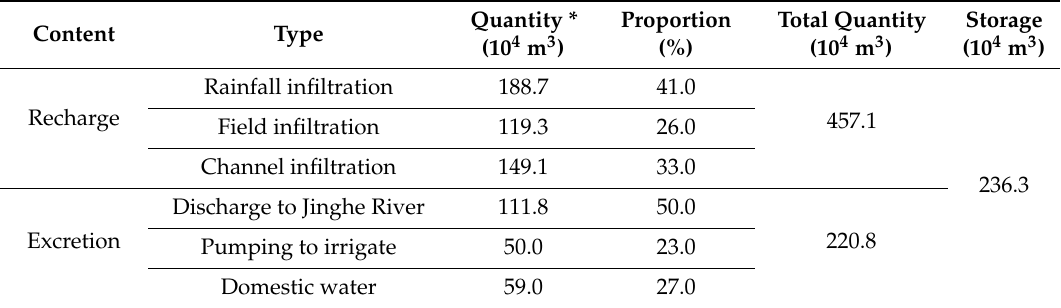
Table 2. Estimated equilibrium phreatic water values in an e ff ective irrigation area of 62.9 km 2 on the South Jingyang Plateau.